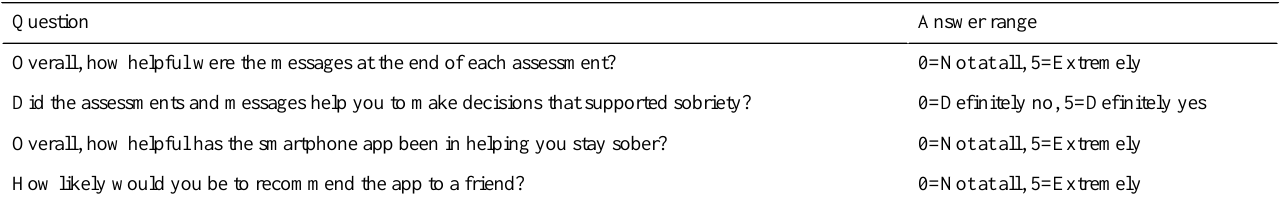
Table 4. Example acceptability items.